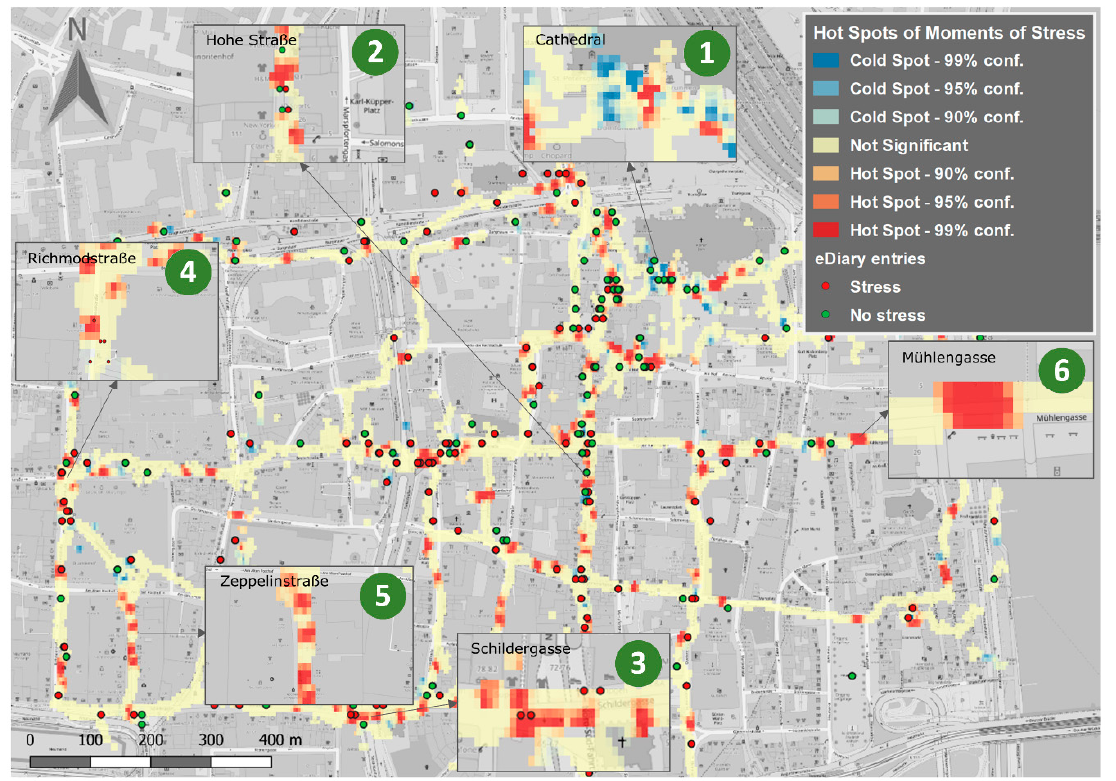
Figure 4. Walkability-related hot spots (stress clusters) and cold spots (areas of relaxation) in Cologne.